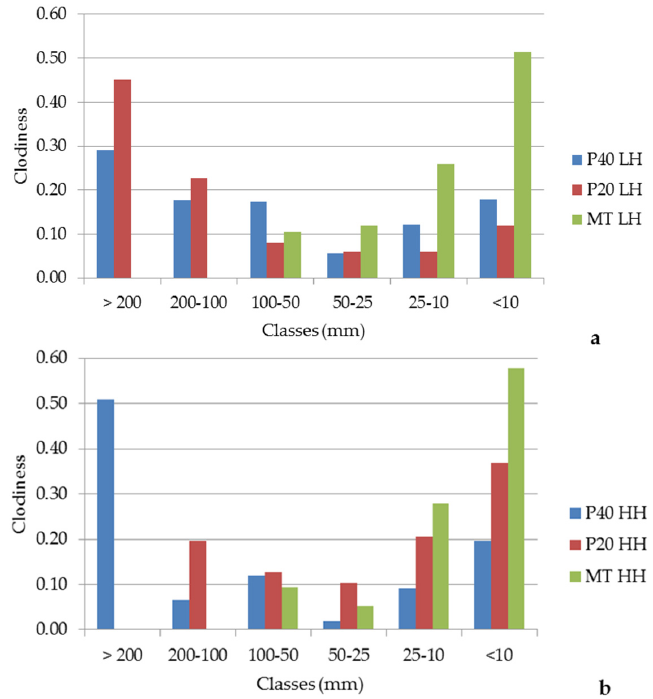
Figure 2. Clod size distribution of different treatments: ( a ) for LH (58% FC) and ( b ) for HH (80% FC).